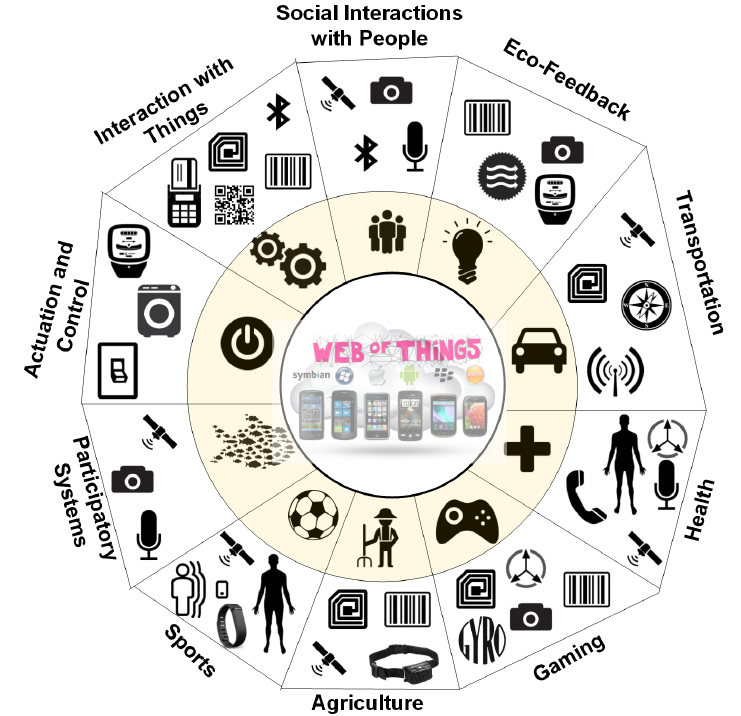
Figure 1. The eco-system of location-based mobile phone IoT applications (Source: